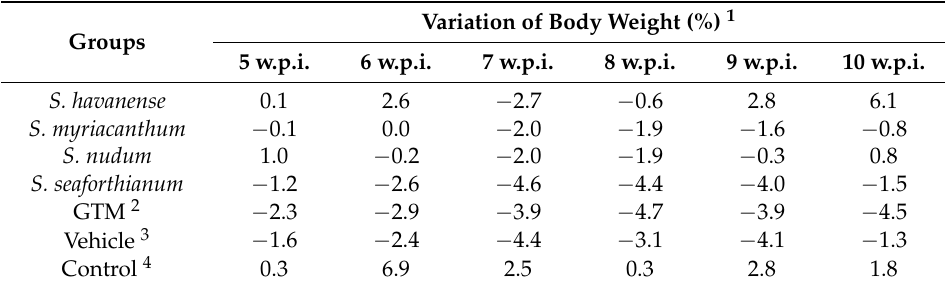
Table 2. Variation of body weight (%) of the animal groups infected with L. amazonensis and treated with Solanum extracts, a vehicle or a reference